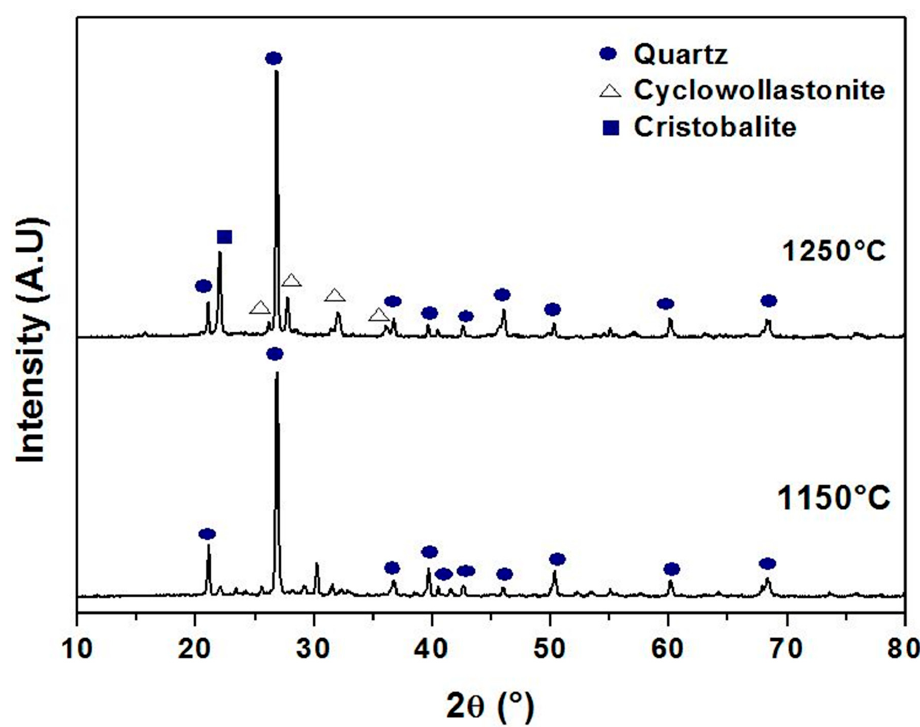
Membranes 2023 , 13 , x FOR PEER REVIEW Figure 8. XRD spectra of support samples sintered at 1150 °C and 1250 °C for 1 h. Figure 8. XRD spectra of support samples sintered at 1150 ◦ C and 1250 ◦ C for 1 h. The flexural strength values were taken as the average of the measurements on five rectangular shape samples, using the bending three points test. Results for samples sin- tered at different temperatures are shown in Figure 9. There is a decrease in flexural strength when the sintering temperature is increased. As examples, for a sintering tem- perature of 1150 °C and 1 h heating, a flexural strength of 20 MPa, a porosity ratio ≈ 53%, and an APS ≈ 5 μ m were found. In the case of an increased temperature to 1300 °C, the following values were found: flexural strength of 12 MPA, porosity ratio of 44%, and APS